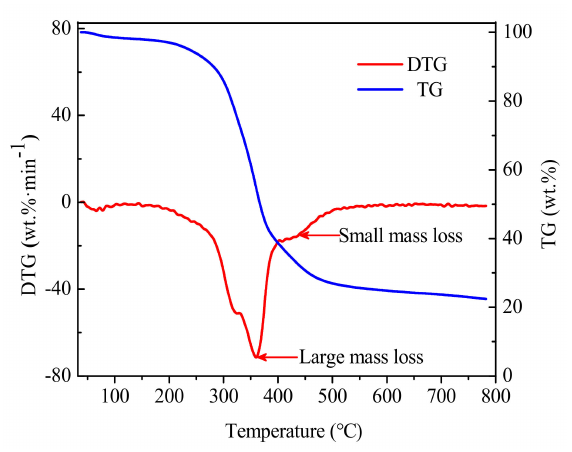
Figure 3. Thermogravimetric graph from coffee grounds under the heating rate of 10 ◦ C · min − 1 and 30 mL · min − 1 nitrogen